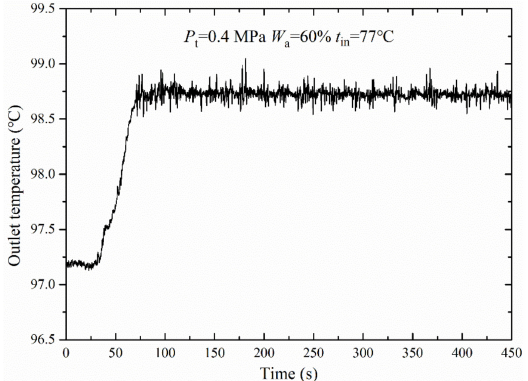
Figure 9. The variation of outlet cooling water temperature in the heat